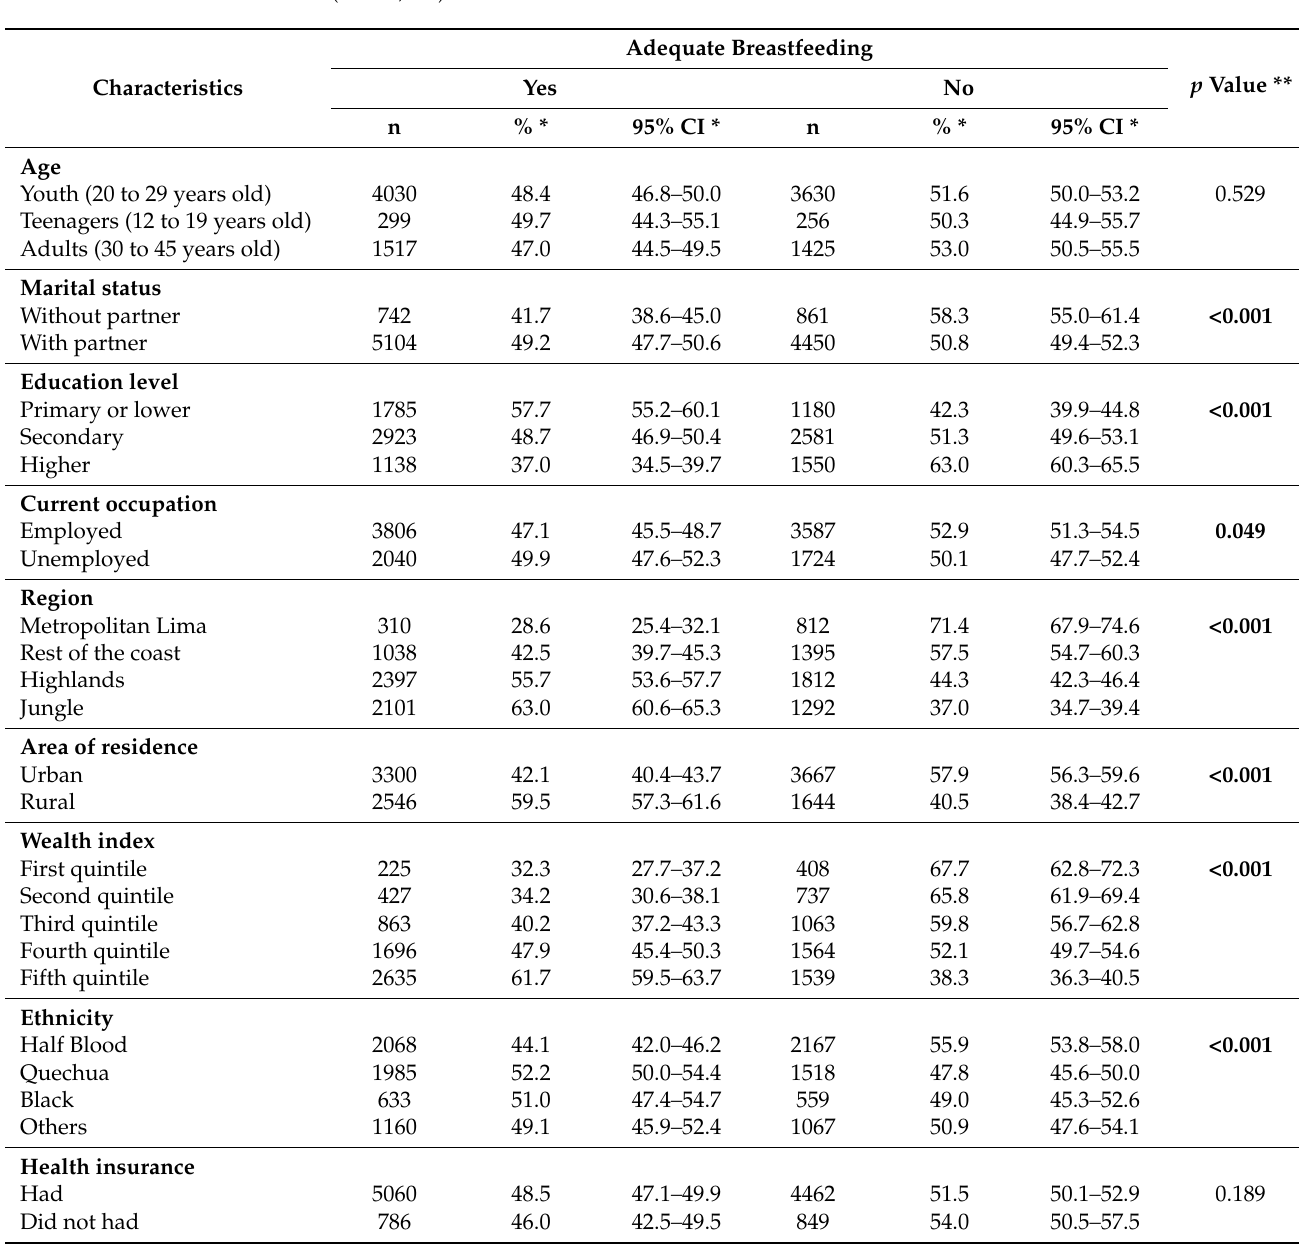
Table 2. Prevalence of adequate breastfeeding, according to the characteristics of the study population (n =